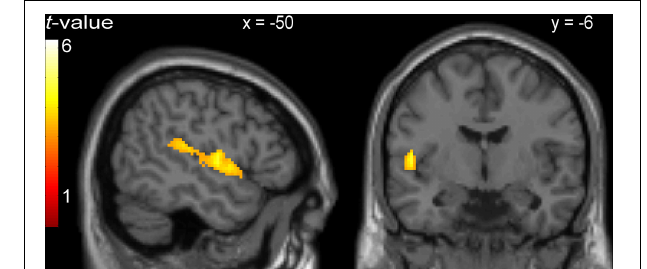
FIGURE 2 | Activity common to incongruent stimuli in the picture-word interference, Stroop, and Simon tasks in a cluster comprising